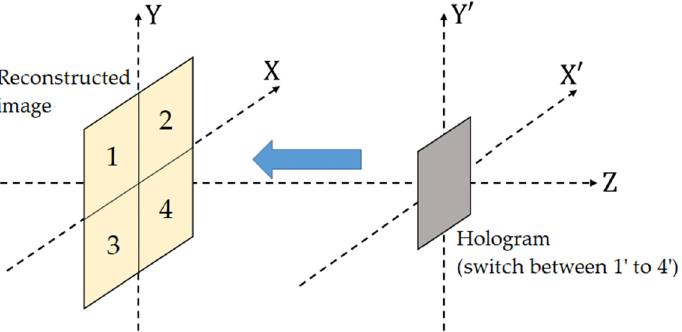
Figure 3. Recording of CGH using time-division reconstruction method: ( a ) recording of divided original image 1, ( b ) recording of divided original image 2, ( c ) recording of divided original image 3, and ( d ) recording of divided original image 4.